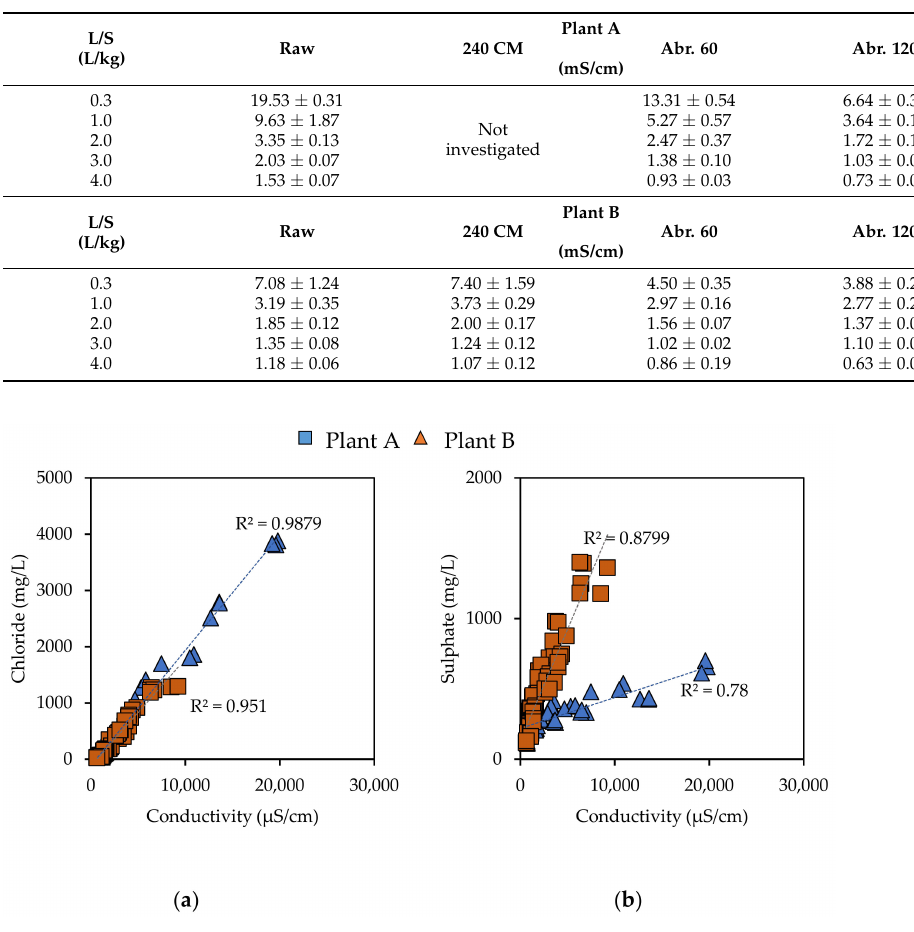
Table 3. Electrical conductivity values measured in leachates, obtained at different L/S ratios. (Raw: untreated sample; 240 CM: samples treated in the concrete mixer for 240 min; 60–120 Abr.: samples treated in the sieving drum for 60 and 120 min abrasion (Abr.) time respectively).